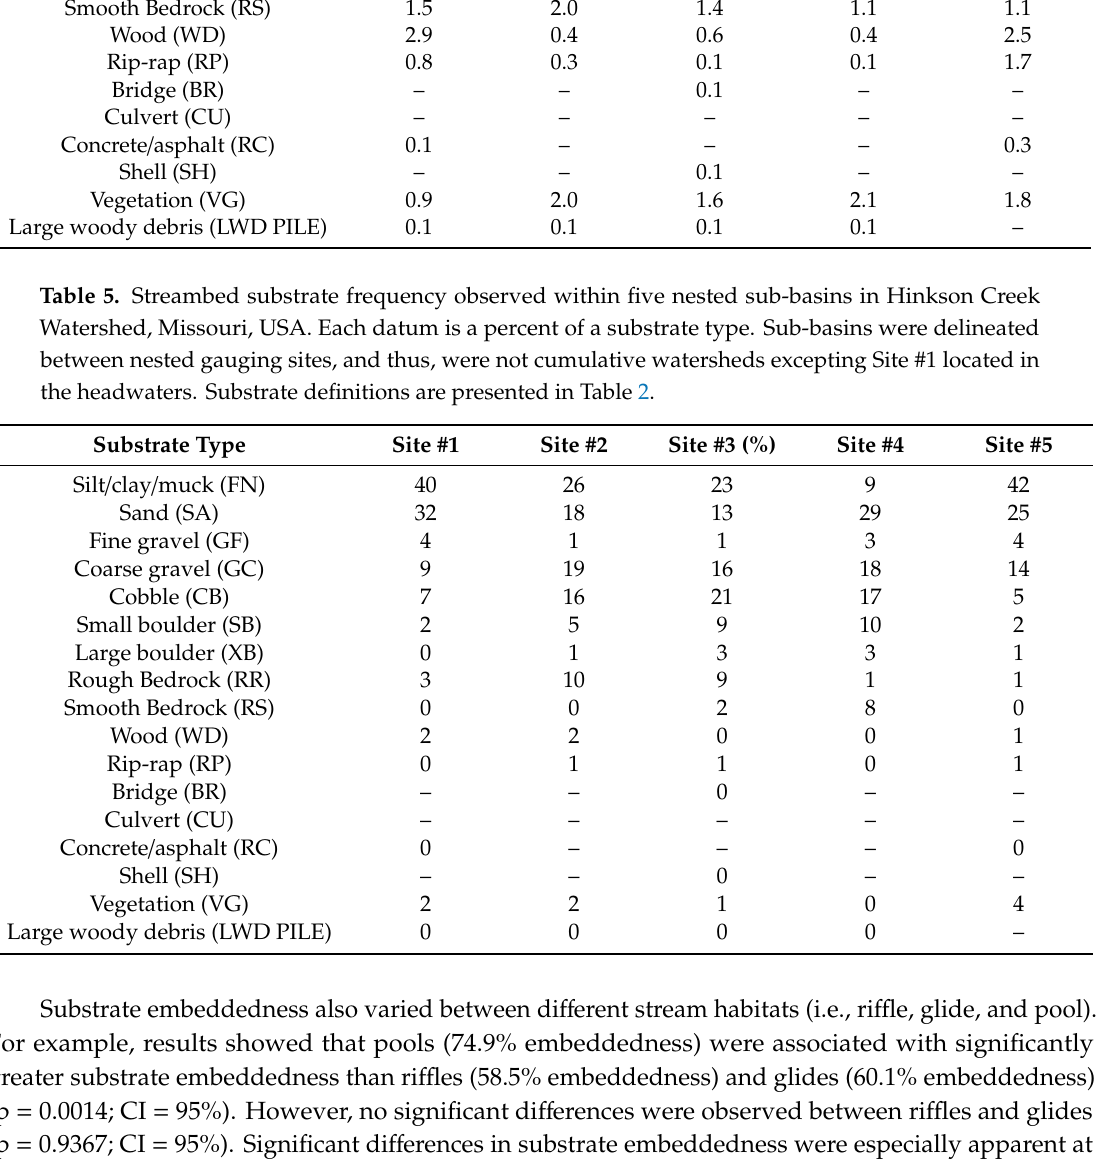
Concrete / asphalt (RC)